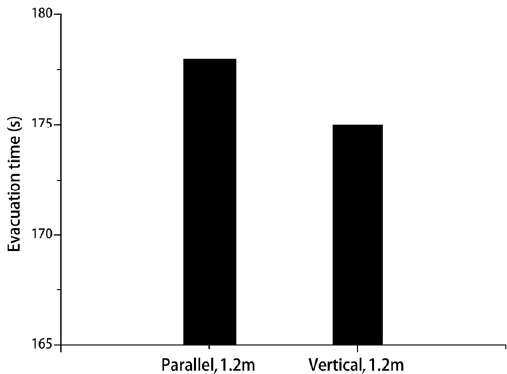
ff erent schemes.